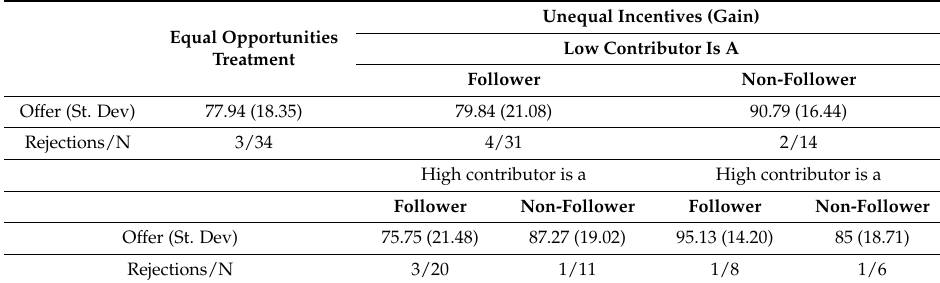
Table 8. Distribution offers and Negotiation Failure of High Contributors in the Gain Treatment in case of unequal contributions, differentiated for followers and non-followers among high and low